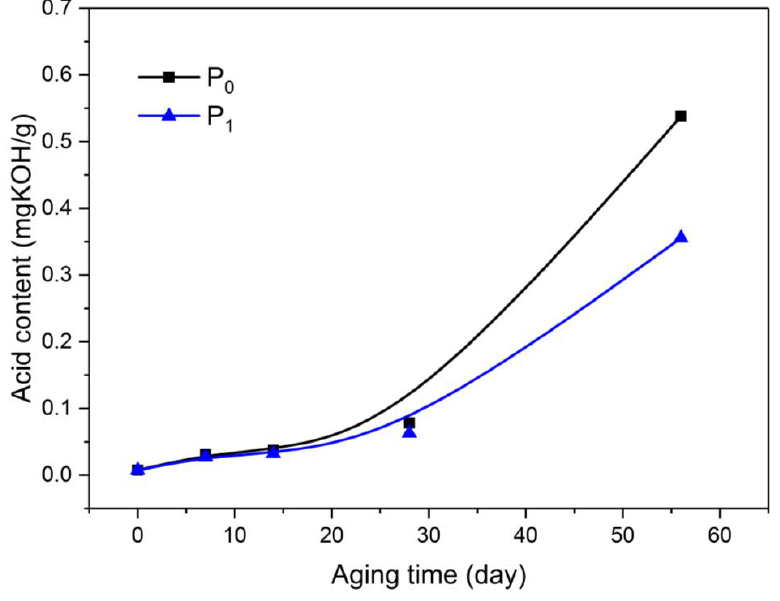
Figure 6. Variation of acidity in oil with aging process.